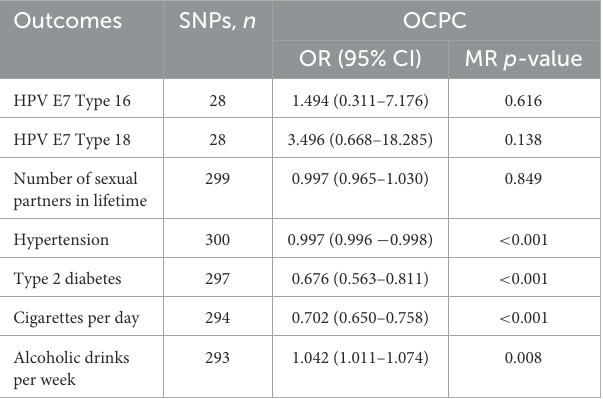
TABLE 2 Causal effects of EA on common risk factors of OCPC according to IVW method.